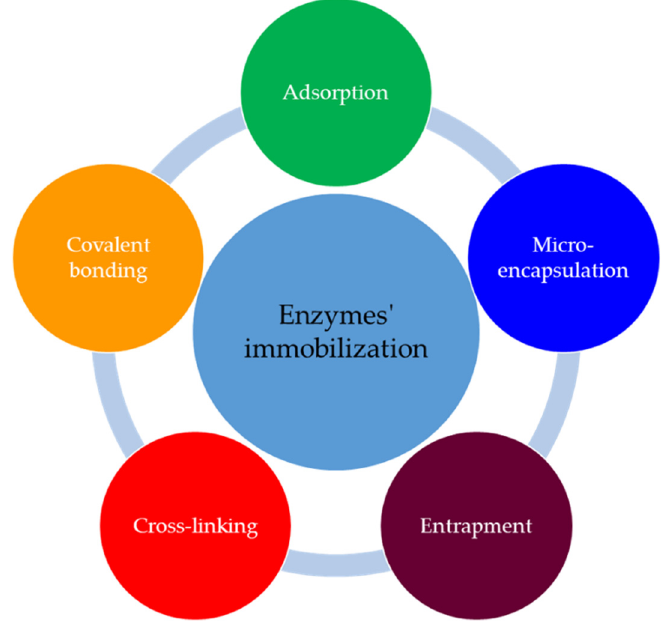
Figure 4. Methods for immobilization of the enzymes. Table 1. Methods of enzyme immobilization for biosensors [52,53].